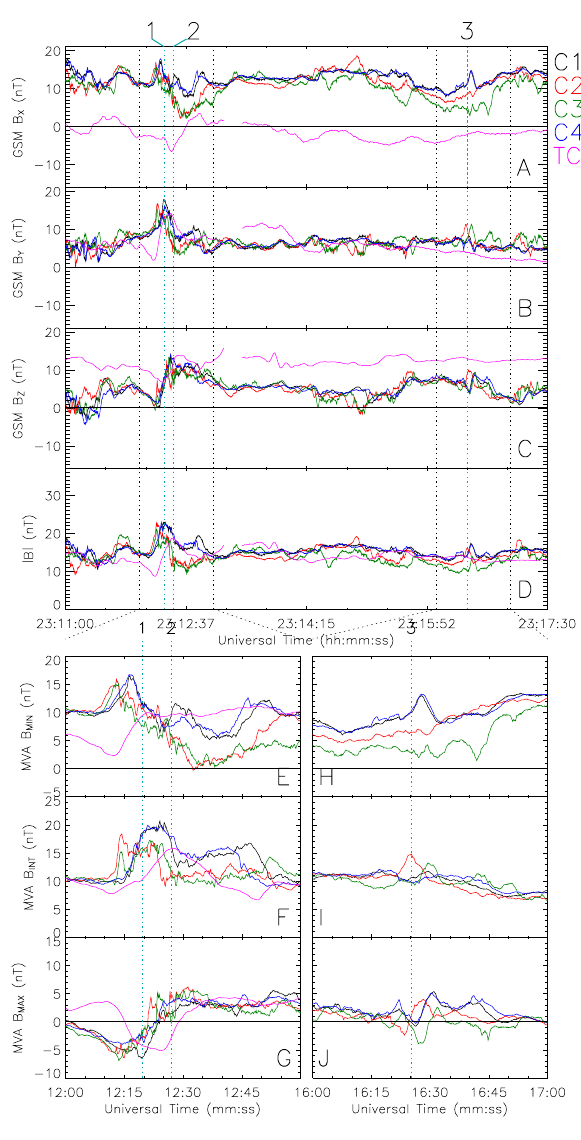
Fig. 2. Flux rope signatures for all four Cluster spacecraft and TC-1 (trace colors as for Fig. 1, panel D ). Panels (A–C) show the three GSM components of the magnetic field, and panel (D) the magni- tude of the magnetic field. Panels (E–G) show Signatures 1 and 2 in minimum variance coordinates. Panels (H–J) show Signature 3 in minimum variance coordinates. The Cluster data in Panels (E– J ) are in a minimum variance coordinate frame calculated from C2 & Signature 3, while the TC-1 data are in a coordinate frame calcu- lated from Signature 2.